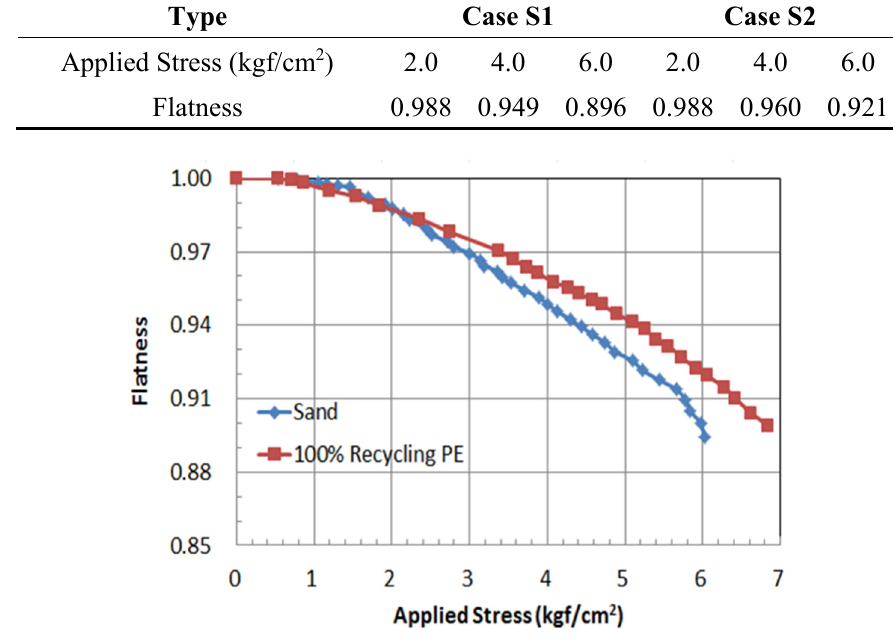
Figure 4. The flatness of PE pipe with applied